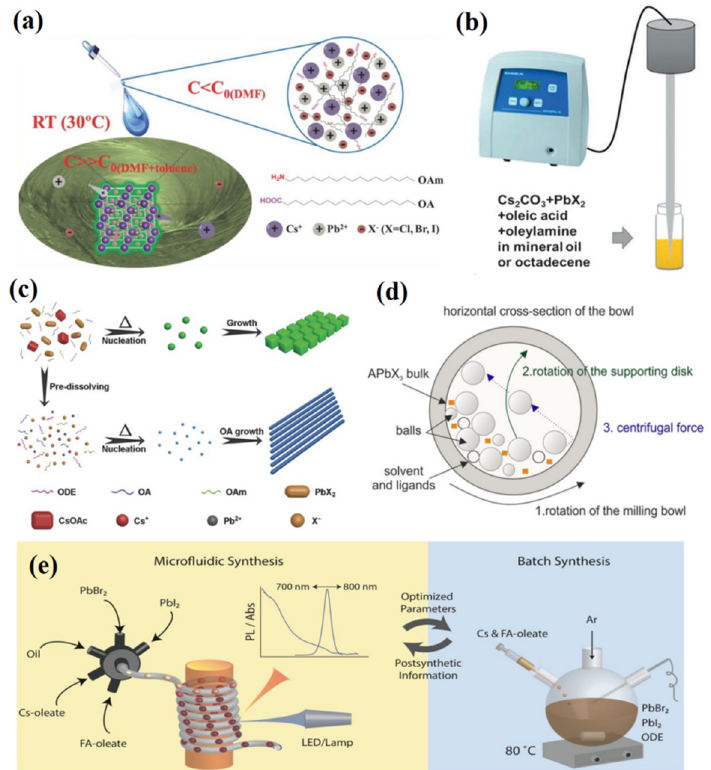
Figure 4. ( a ) Room-temperature precipitation method. Reproduced with permission from [49]. Copy-